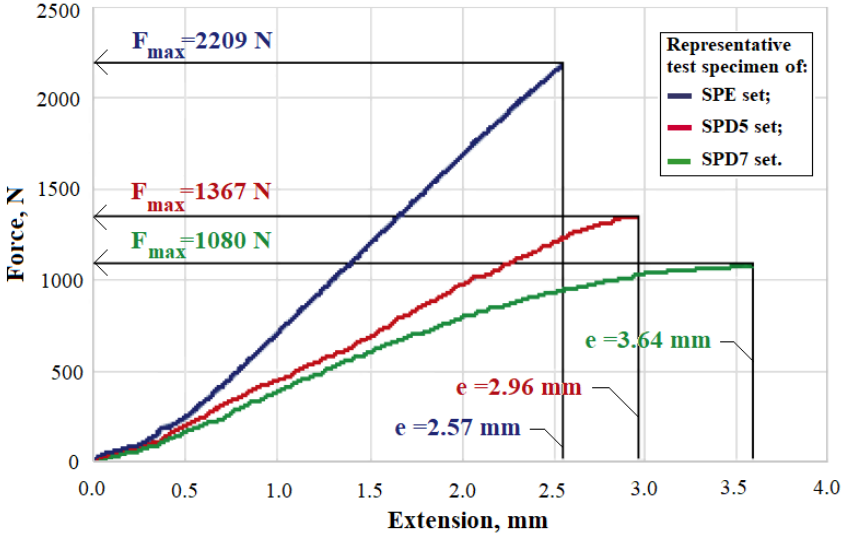
Figure 12. Strength–extension diagram for representative specimens from sets SPE, SPD5 and SPD7.